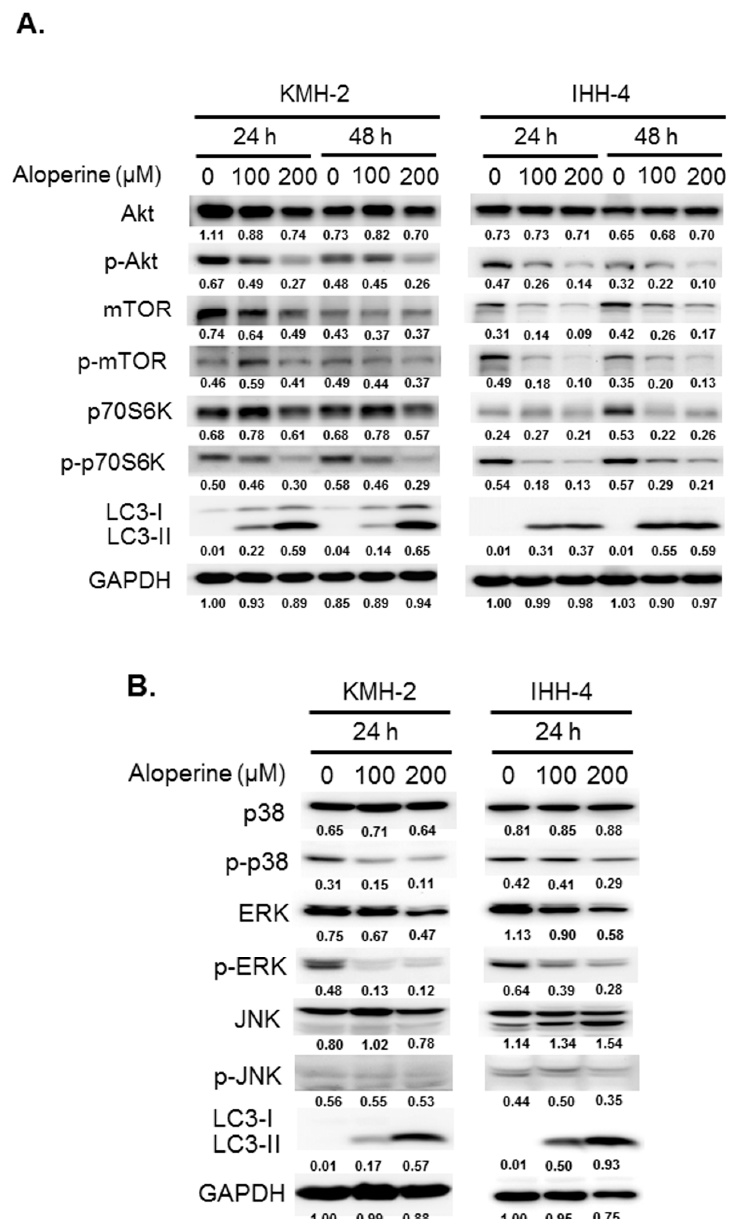
Figure 5. Signaling pathway modulation in human thyroid cancer cells following aloperine treatment. The signaling pathways including ( A ) Akt / mTOR / p70s6K and ( B ) Erk, p38, and JNK pathways were examined in cells with or without aloperine treatment. DMSO was used as a negative control. Numbers under the plots indicate the quantification of protein intensity after normalization with GAPDH.